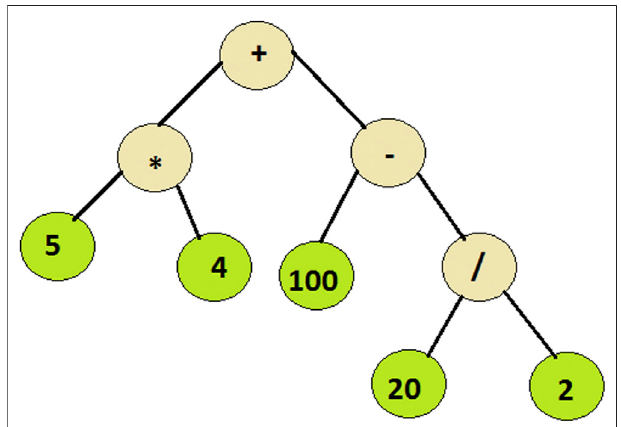
FIGURE 1 | An expression tree example: the program traverses the tree from right to left evaluating the encountered functions from bottom to